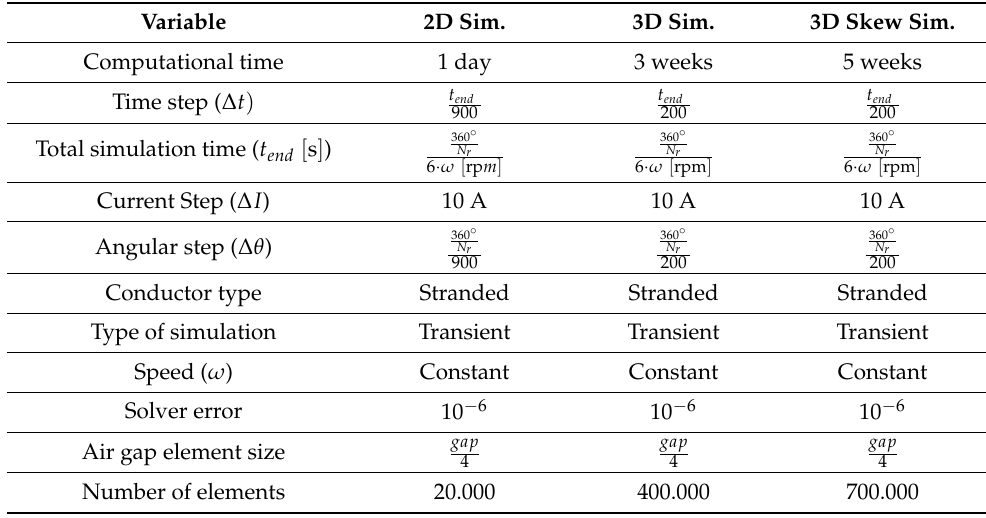
Table A1. Parameters values for 2D and 3D simulations.